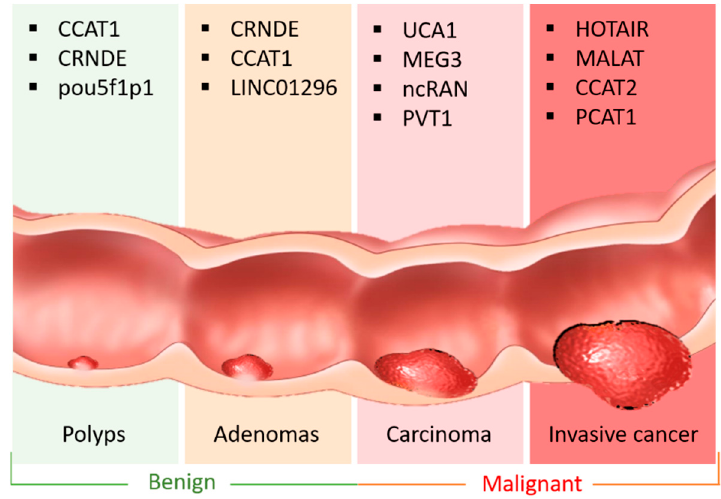
Figure 1. Representative lncRNAs in the different stages of CRC. There are four major stages of CRC CRC development: precancerous polys, Adenomas, Carcinoma and invasive cancer. development: precancerous polys, Adenomas, Carcinoma and invasive cancer. Representative lncRNAs involved in the certain stages could be regarded as early-stage diagnostic biomarkers to evaluate CRC progression or therapeutic targets to suppress CRC metastasis.